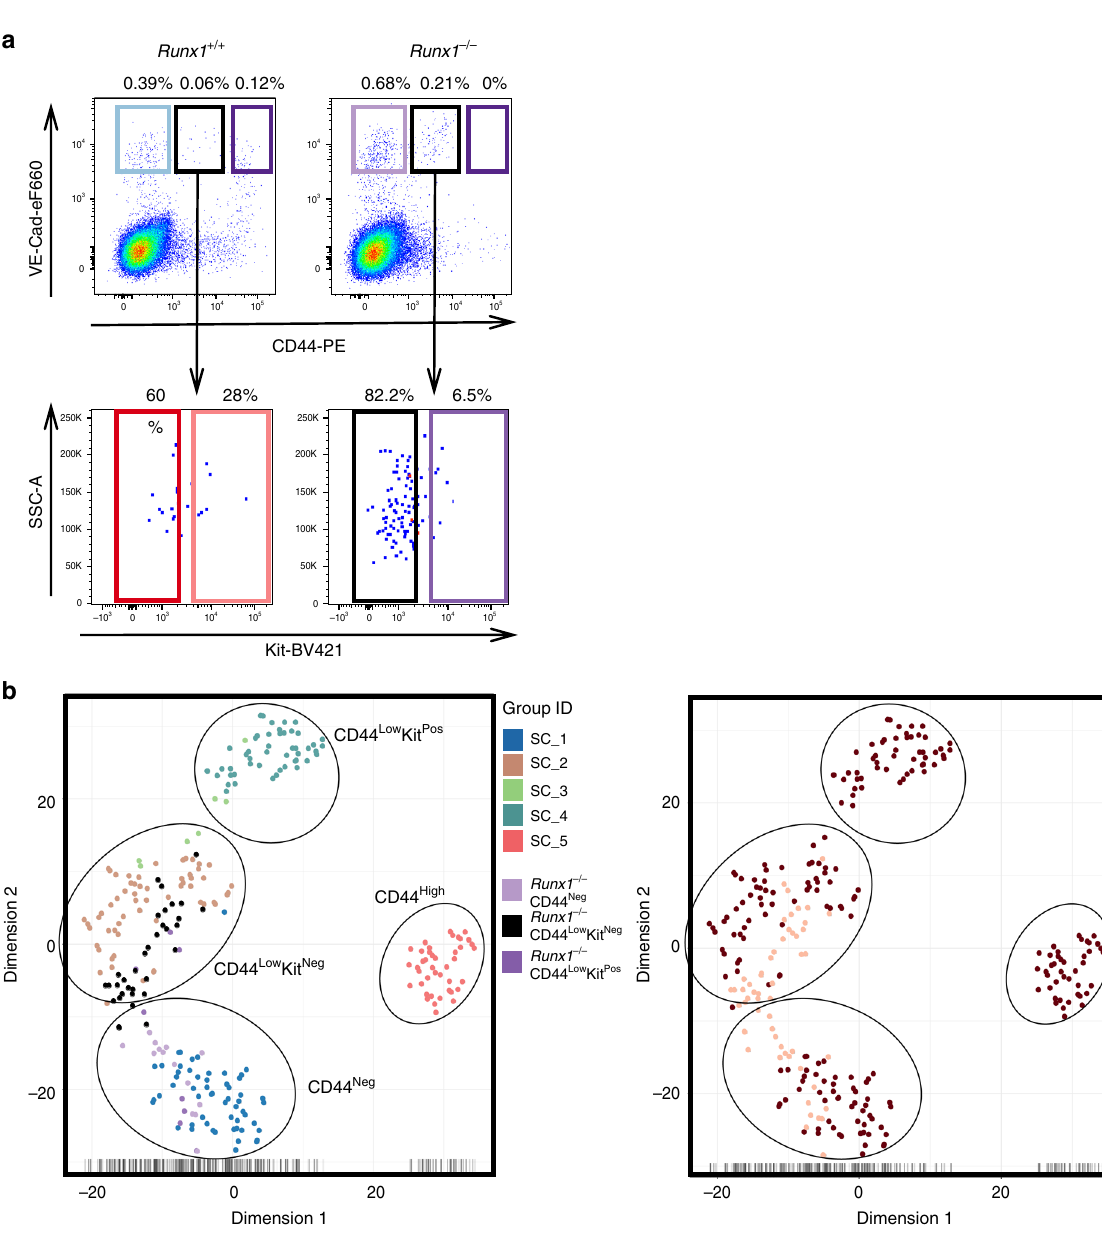
Fig. 6 Reduced expression of genes involved in TCA cycle and glycolysis in CD44 Low Kit Neg endothelial cells. a , b Overview of key metabolic nodes and pathways enriched in differentially expressed genes when comparing the CD44 Low Kit Neg and CD44 Neg endothelial populations. These were selected based on reporter metabolite analysis. Pathway boxes summarize multiple genes/reporter metabolites (Supplementary Data 8). The mentioned upregulated and downregulated genes refer to the expression in the CD44 Low Kit Neg population compared with CD44 Neg . c Cell proliferation analysis of the four indicated populations showing a representative fl ow cytometry pro fi le of cell cycle status (top panel) and a bar graph summarizing the proportion of cells in G0/G1 cell cycle phases for each population (bottom panel) ( n = 4 independent experiments). Error bars represent SD. A one-way ANOVA was used to compare the proportion of cells in the G0/G1 phase across all populations F(3,12) = 30.24, p -value < 0.0001. A Tukey ’ s HSD post-hoc test was used to determine where the signi fi cance lies, * p -value < 0.05, ** p -value < 0.01, *** p -value < 0.001. Source data are provided as a Source Data fi le.